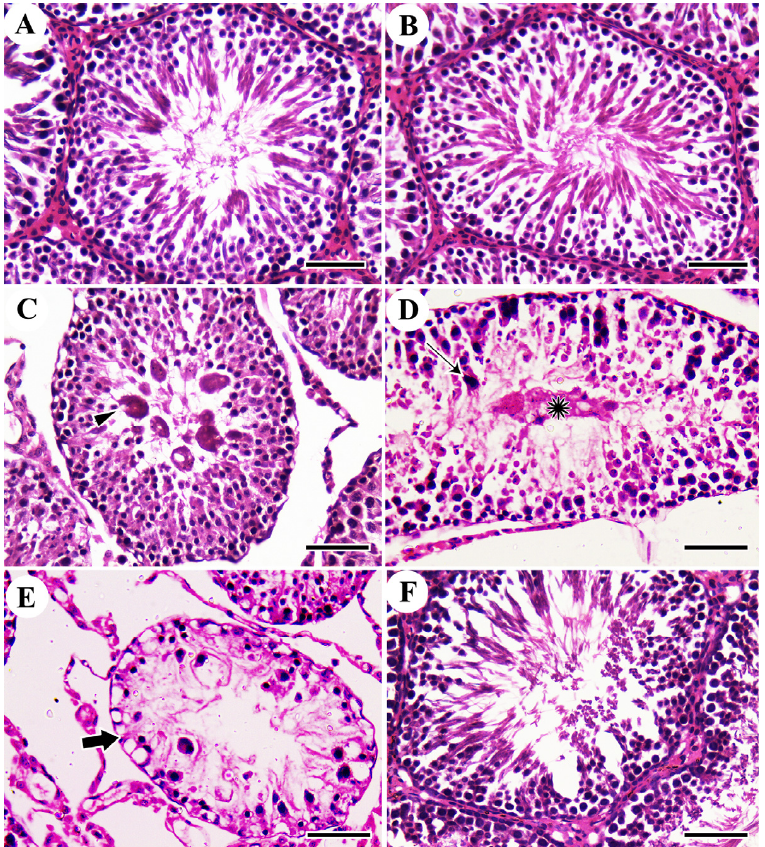
Figure 2. Histopathological examination of rat testis. ( A ) Control group; ( B ) Moringa olifera leaf extract (MO-ZNPs)-treated group; ( C – E ) Acrylamide (ACR)-exposed group showing multinucleated giant cell (arrowhead), necrosis of tubular epithelium (thin arrow), coagulative necrosis with luminal content hyalinization (aster), and atrophied seminiferous tubules with marked reduced numbers of necrotic germinal cells (thick arrow); ( F ) ACR+ MO-ZNPs. Scale bar = 50 µm.